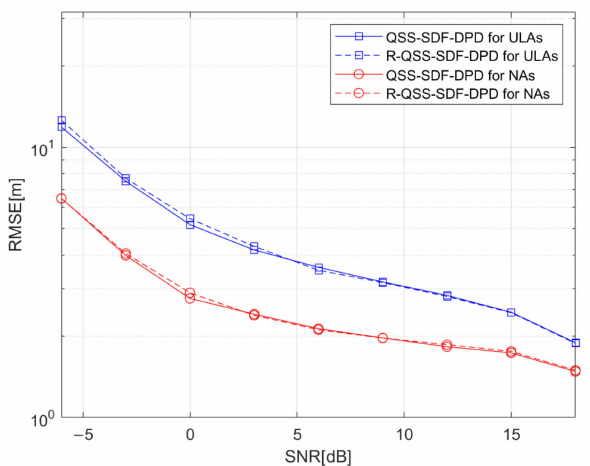
Figure 6. Comparison of QSS-SDF-DPD and R-QSS-SDF-DPD algorithms by RMSE versus